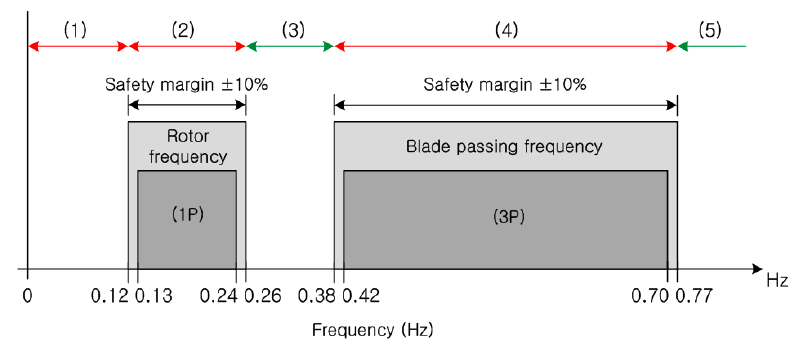
Figure 15. Design ranges for the fundamental frequency of WinDS3000.